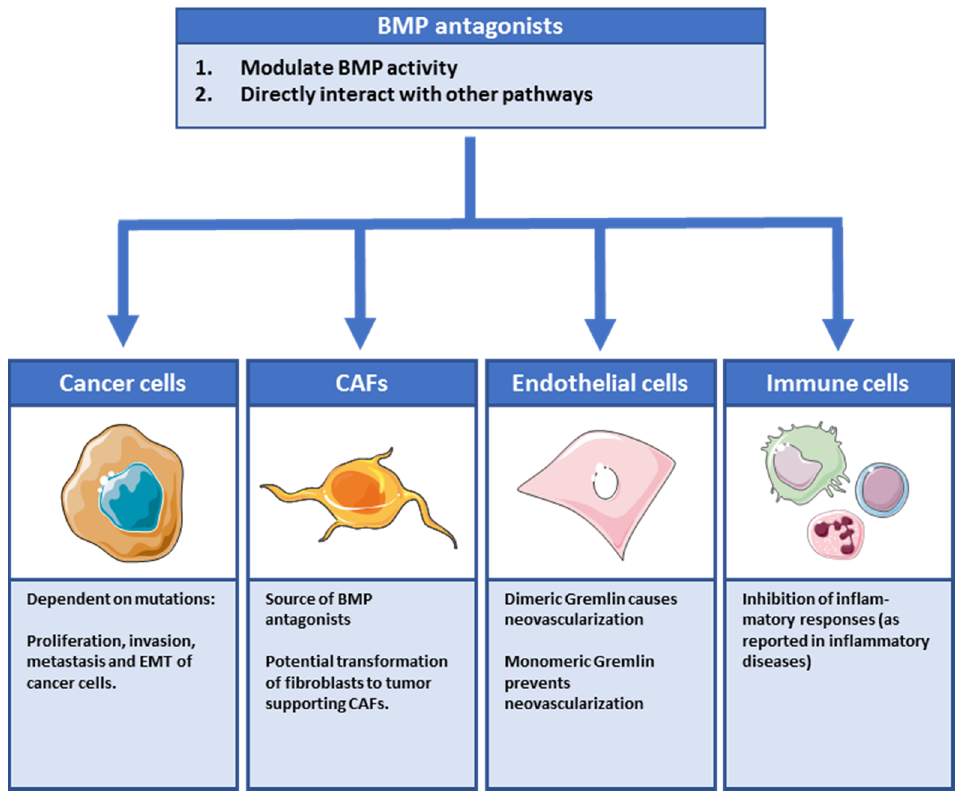
Figure 3. Overview of effects of BMP antagonists on cells in the tumor microenvironment. Regarding effects of BMP antagonists, many studies with conflicting data have been reported. There are multiple ways by which BMP antagonists can influence cancer progression as different cell types, apart from the cancer cells, can be affected.